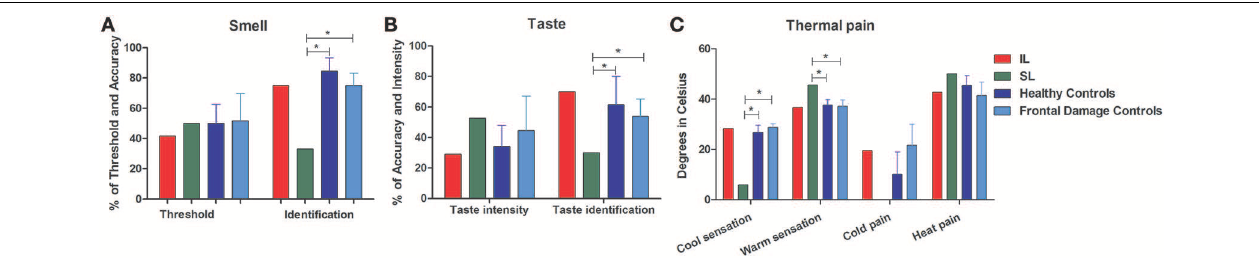
FIGURE 2 | External stream: smell, taste, and pain. The figure shows the results of tasks evaluating the external stream of interoception, demonstrating SL patient’s impairment and IL patient’s normal performance